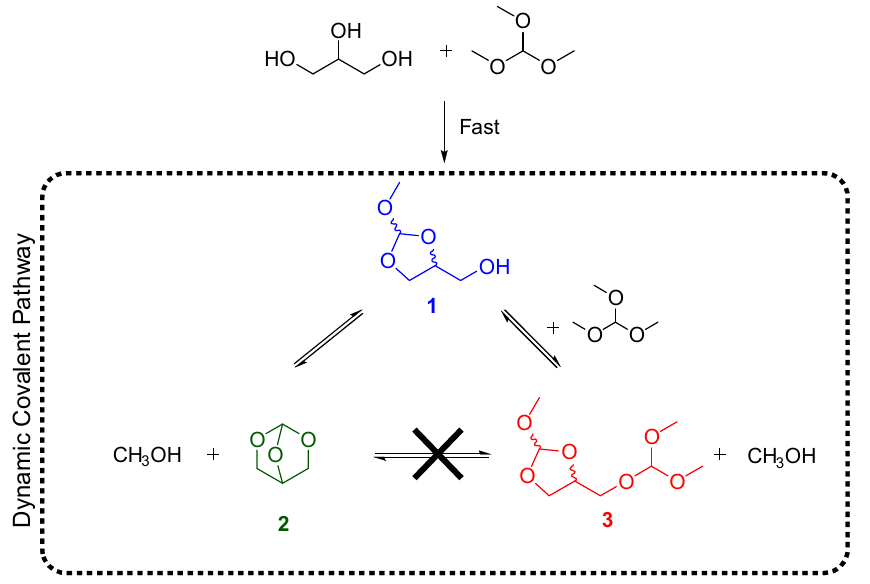
Scheme 1. Pathways for the Gly and HC(OMe) 3 reaction.